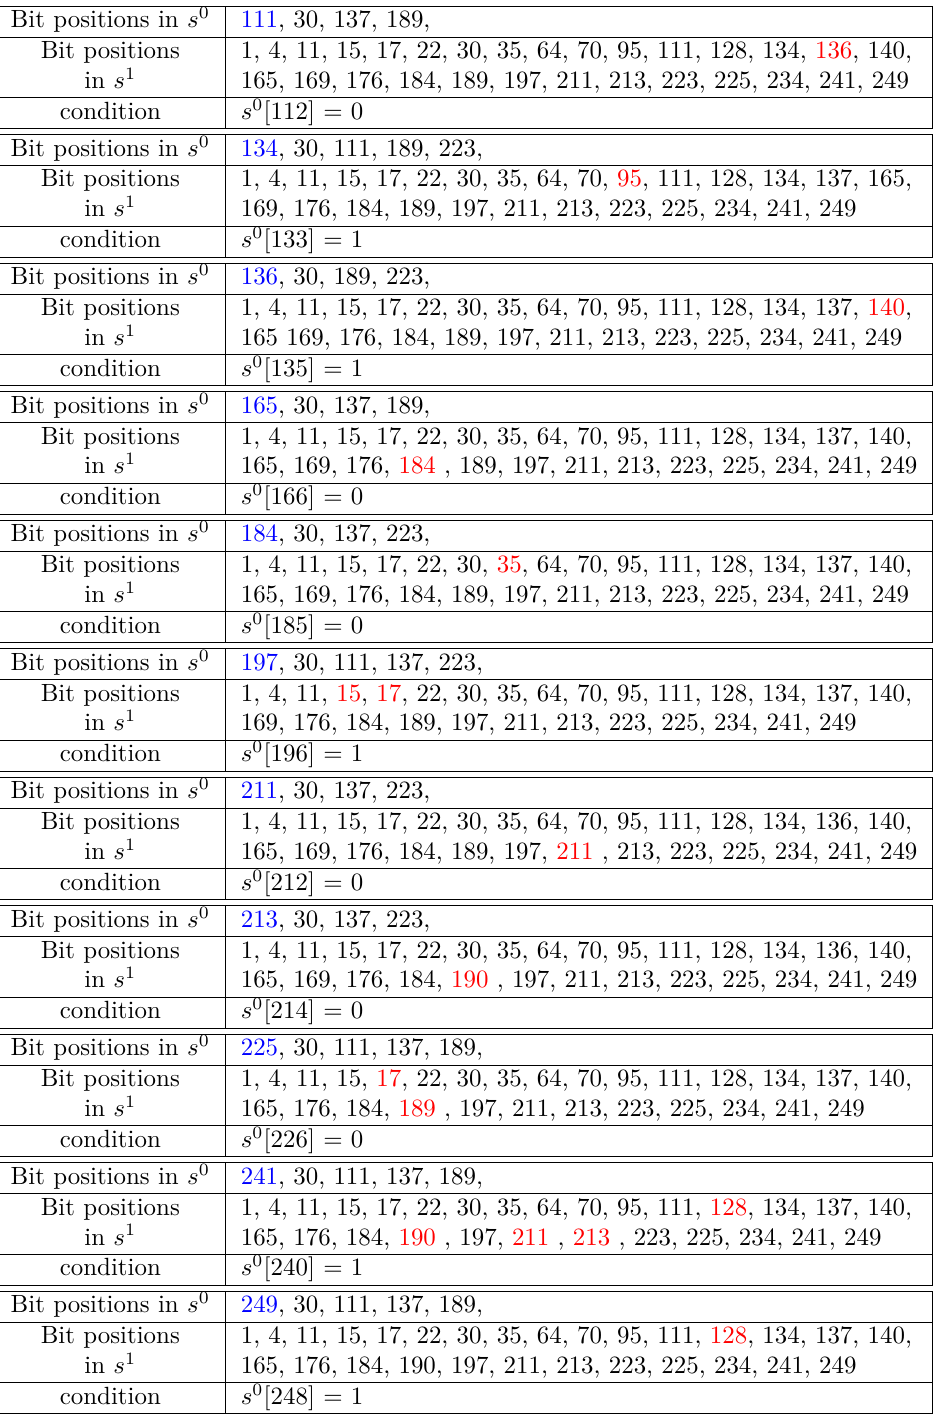
Table 11: Cube variables for conditional cube